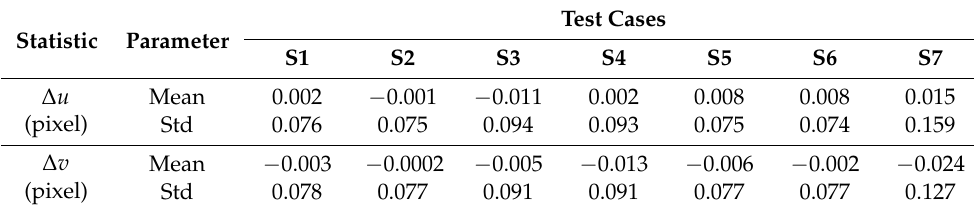
( b ) Figure 14. ( a ) Temporal evolution of the centroiding errors over a single simulation for test case S3; ( b ) partial loss of marker #6 at 320 s. As for test case S7, a larger error on t z is caused by the partial shadowing of some markers during the approach of the chaser towards the target. In fact, the markers illumi- nated by both the 850 nm length and the sunlight will appear brighter than the ones shad- owed by the chaser body, causing the global threshold to shift towards higher values. As a result, the darkest pixels of those markers that are partially shadowed will have a higher chance of being excluded by the thresholding, introducing errors in the centroiding pro- cess. However, the peaks in the pose error (Figure 15), which are coherent to those in the centroiding error (Figure 16), are still kept small in entity. Overall, the results of the tests S1 to S7 demonstrate that, even though sunlight can influence the detection of the markers, the algorithm is robust to a variety of illumination conditions and is able to preserve its performance.